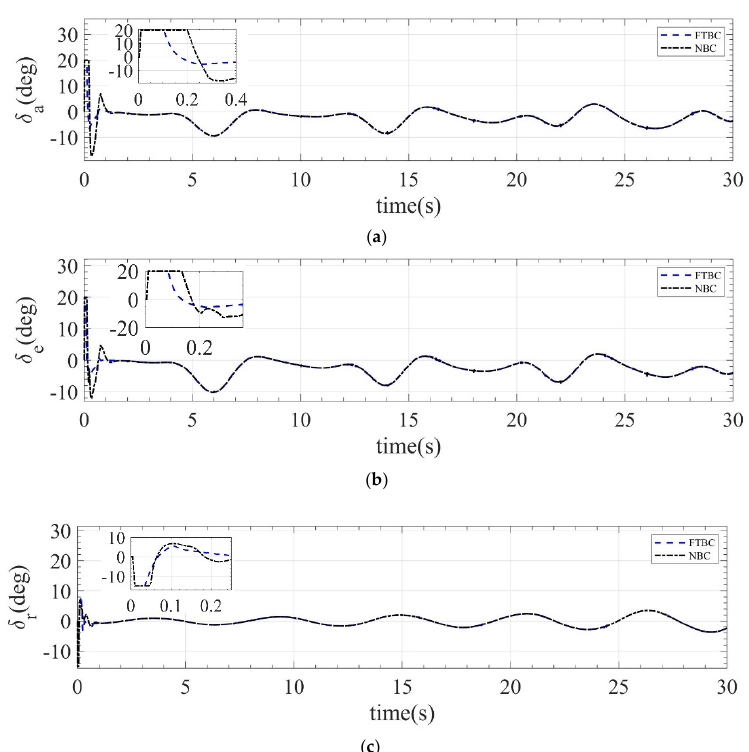
Figure 5. ( a ) Observer error curve of Figure 13. ( a ) Tracking error curve of e p , ( b ) tracking error curve of e q , and ( c ) tracking error curve ( c ) observer error curve of  Δ of e r . chattering problem).